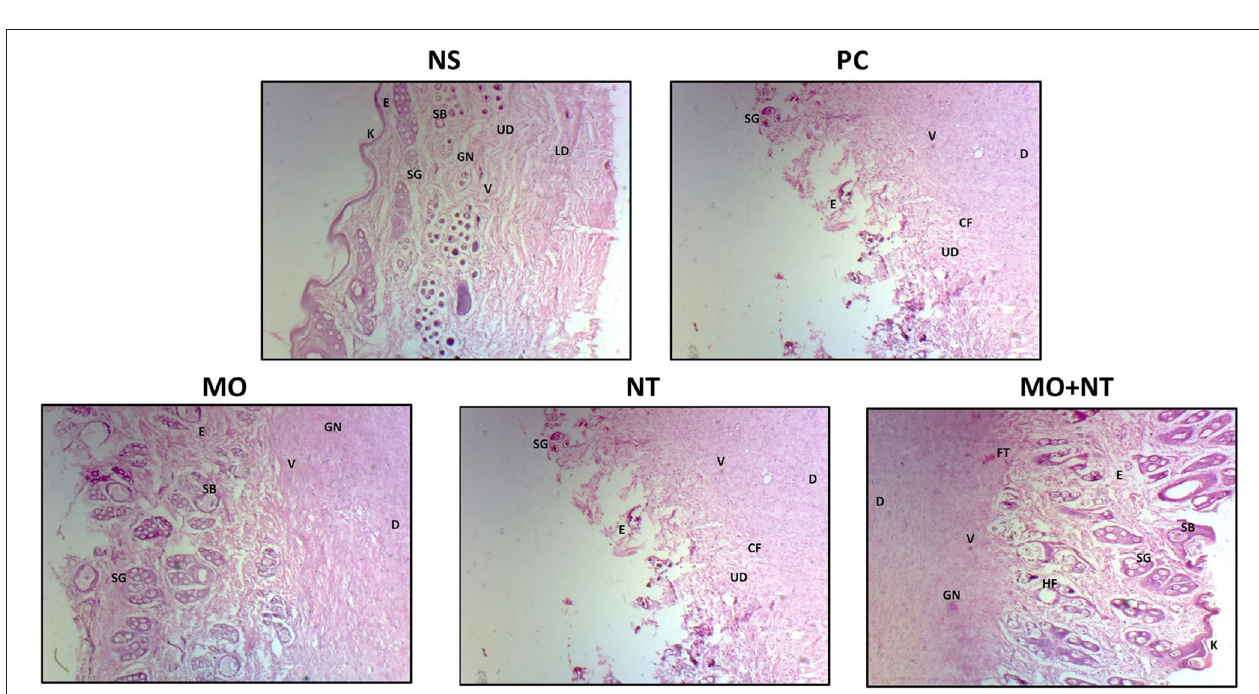
FIGURE 5 | Histopathology of different treatments. E, epidermis; D, dermis; UD, upper dermis; LD, lower dermis; SG, sweat glands; SB, sebaceous glands; V, newly farmed blood vessels; GN, granular tissues or granulation; HF, hair follicle; FT, fibrous tissue or collagen fibers (Cf); K, keratin layer.